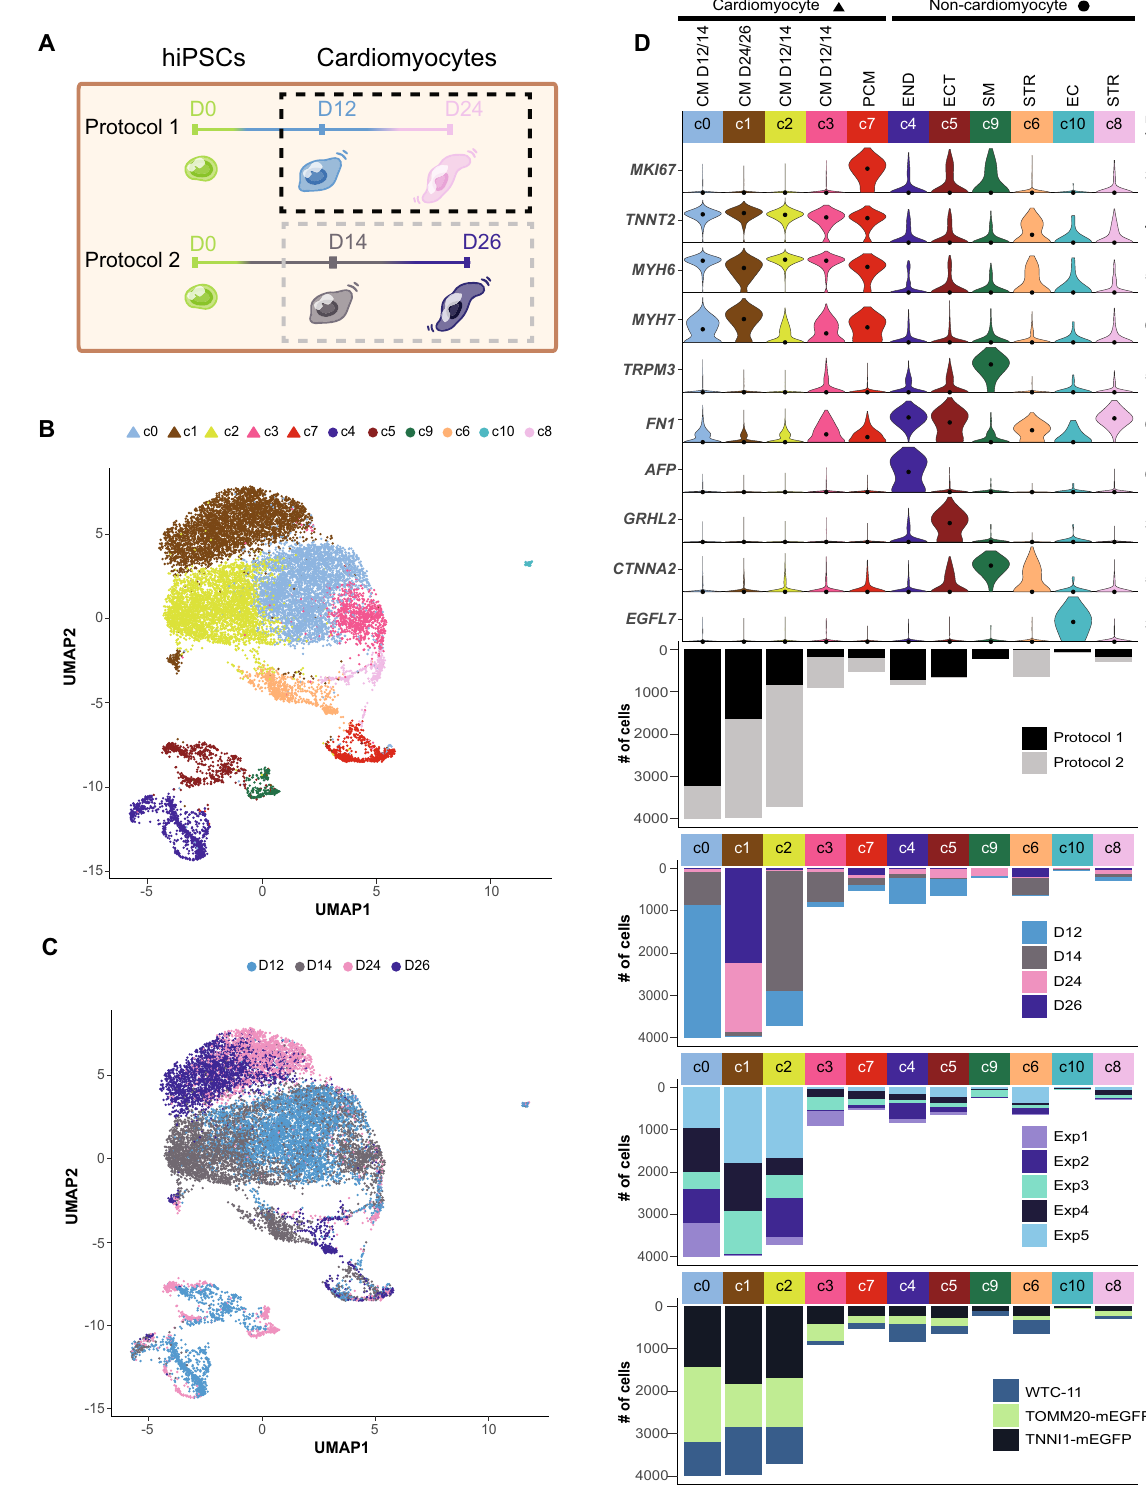
Figure 4. Expanded analysis of samples collected 12, 14, 24, and 26 days after the initiation of differentiation with two directed differentiation protocols. ( A ) Sample collection schematic highlighting collection of cells at early and intermediate time points (dashed boxes) from Protocol 1 (small molecule, D12/D24 cells) and Protocol 2 (cytokine, D14/D26 cells). ( B ) UMAP of early and intermediate time point cells differentiated from both protocols, representing three clonal cell lines and five independent differentiation experiments. Cells are colored by cluster (11 clusters), and shape indicates cardiomyocyte vs. non-cardiomyocyte cluster (triangle = TNNT2 + cardiomyocytes, circle = non- cardiomyocytes). Number of cells: D12 = 5494, D14 = 5135, D24 = 2493, D26 = 2756. ( C ) Same UMAP shown in panel B, colored by collection time point; Protocol 1 (small molecule) = D12 and D24. Protocol 2 (cytokine) = D14 and D26. ( D ) Violin plots showing distributions of transcript abundance for cell type marker genes by cluster from panel B (max value = maximum value of transcript abundance; dot = median). Bar beneath each cluster indicates cluster size (# of cells) and is colored by protocol, time point, differentiation experiment, and cell